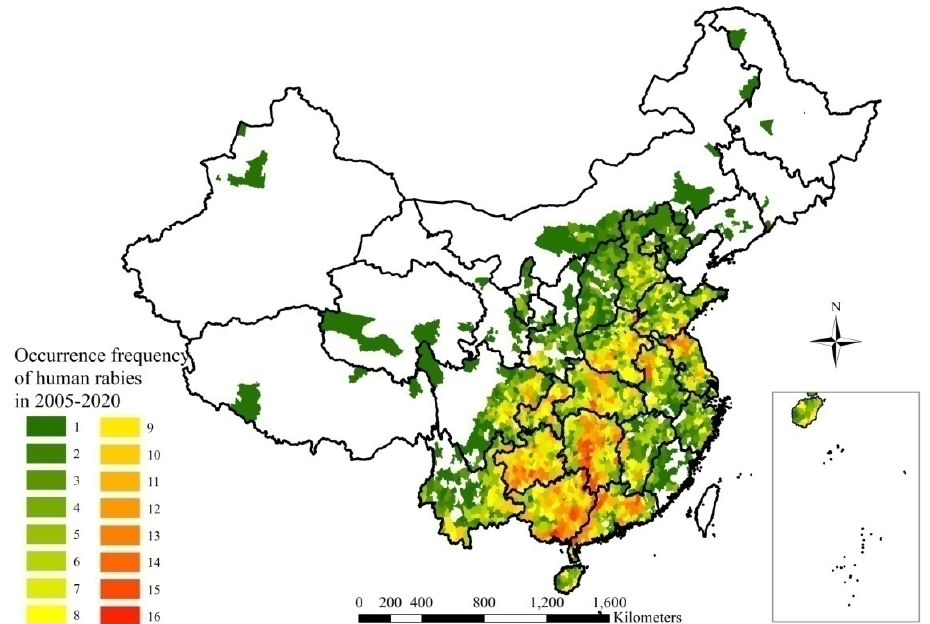
Figure 4. Occurrence frequency of human rabies in mainland China, 2005–2020.